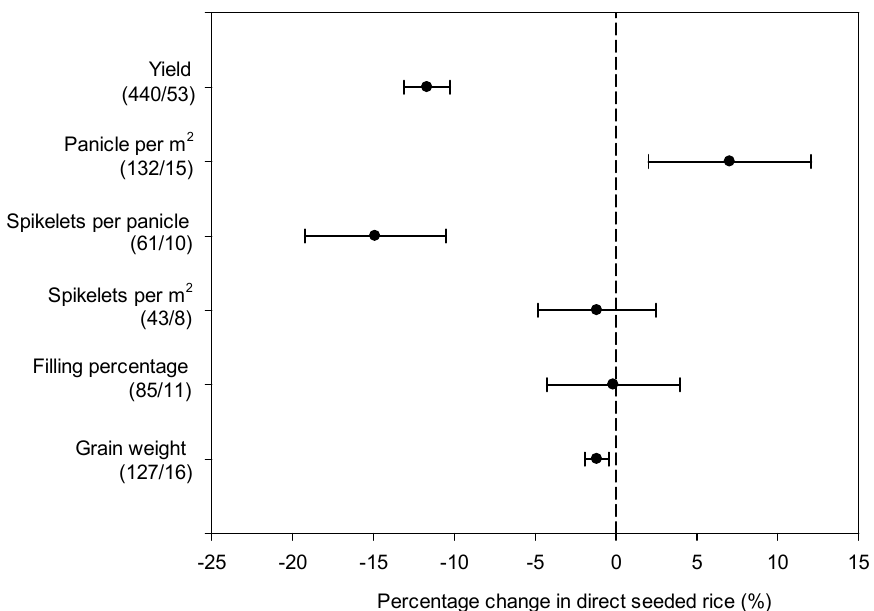
Figure 1. Percentage changes in yield and yield components comparing direct-seeded rice to transplanted rice across a wide range of management and environmental conditions. The number of paired observations / number of studies included in each dataset are presented in parenthesis.